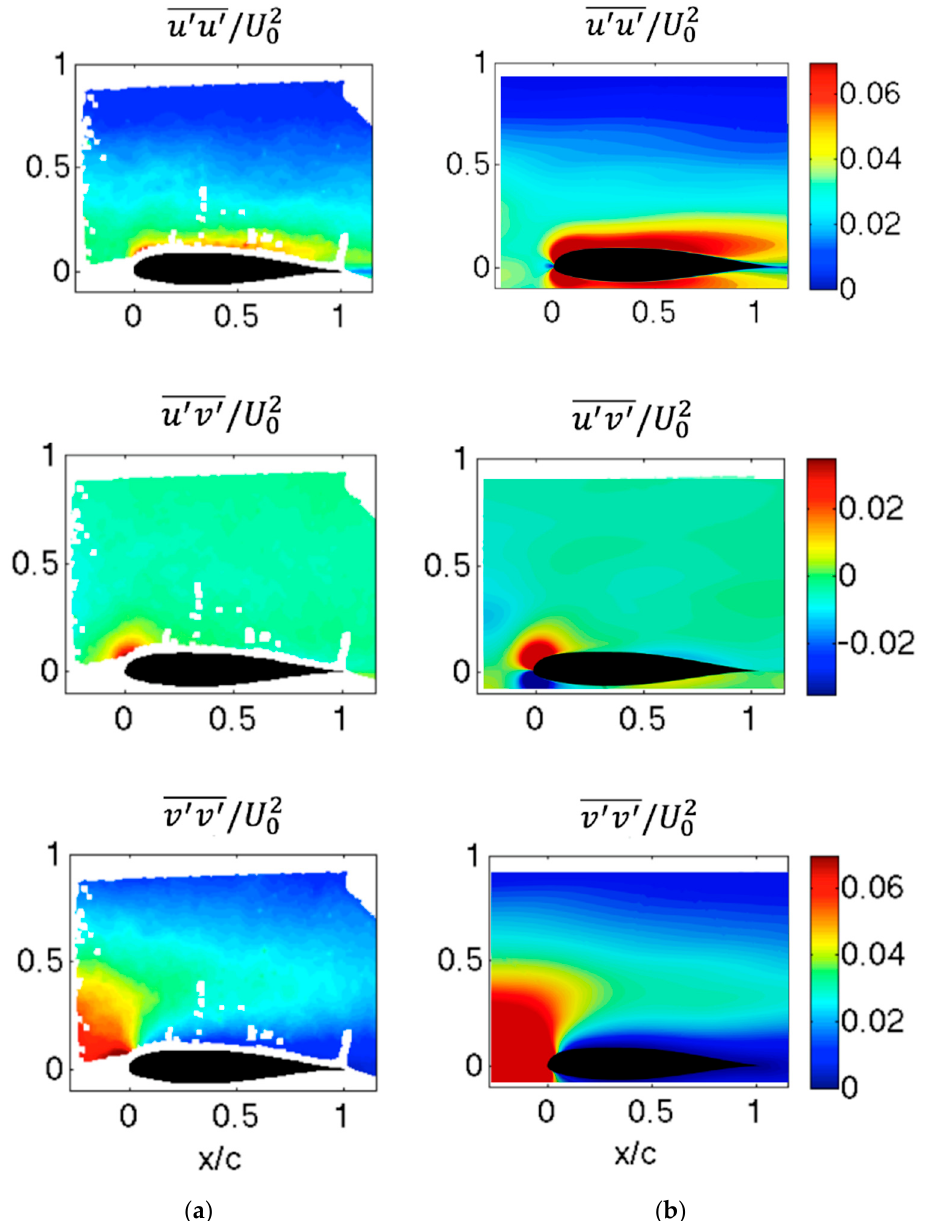
Figure 24. Normalized Reynolds stress components around airfoil in clean flow. ( a ) EFD, ( b ) CFD.